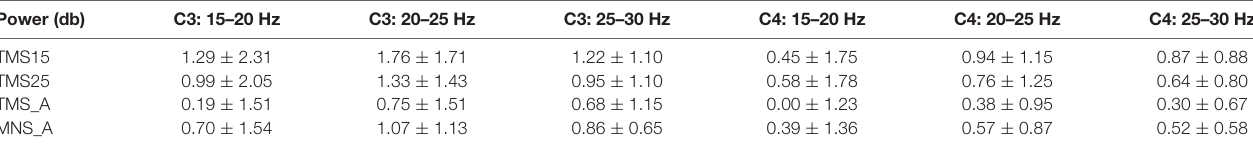
TABLE 2 | Mean power and SD in the three beta bands, respectively, for electrodes C3 and C4. Power